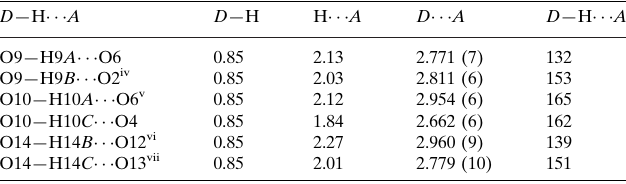
Hydrogen-bond geometry (A˚ , (cid:3)